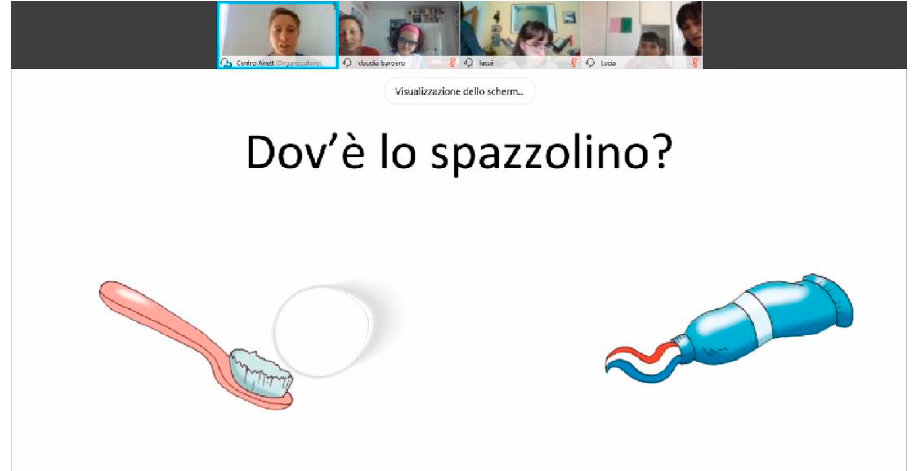
Figure 6. The user interface on the subject's side.